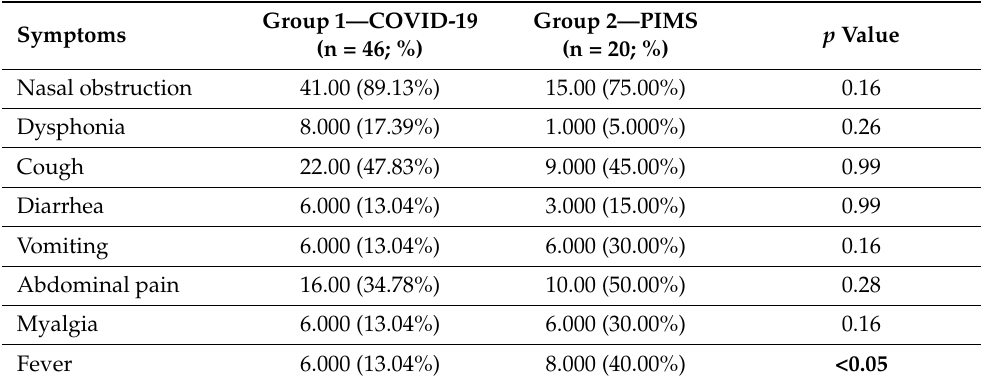
Table 2. The assessment of symptoms in the two